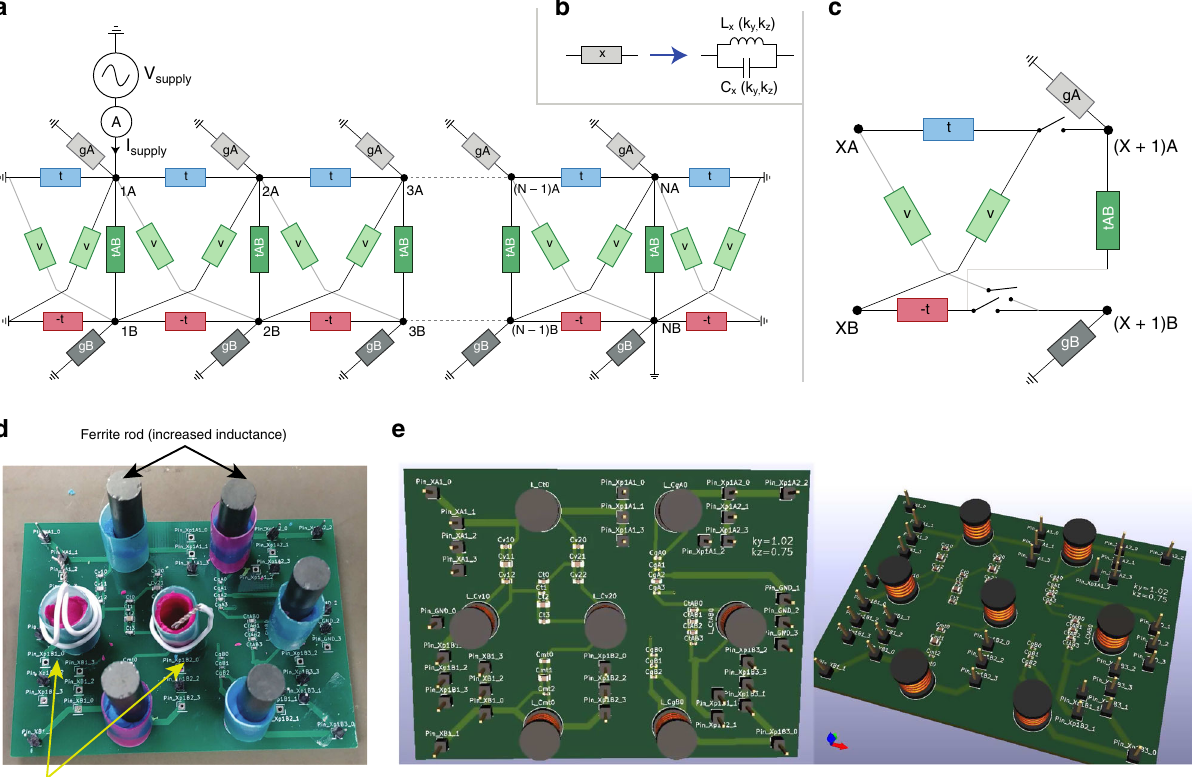
Fig. 6 Schematic and PCB implementation of Hopf-Link experiment. a Schematic of our 2-leg ladder LC circuit array, whose Laplacian takes the form of the Hopf-link at resonance when the component admittances are chosen according to (15) – (18). b Each rectangle in ( a ) corresponds to a parallel combination of an inductor and a logical capacitor whose speci fi cations are indicated in Supplementary Table 1. As explained in the main text, each inductor can be accurately tuned to vary k y , k z near the drumhead region. c Schematic representation of one repeating unit cell of the circuit used to construct fi nal experiment. The switches are set to open when the inductors are being tuned, and closed when the impedance of the entire circuit is measured to map out the drumhead region. d Experimental PCB realization of one repeating unit. Visible are the inductors equipped with ferrite rods or shorted wire loops, which respectively increase/decrease the inductances in a tunable manner. e Renderings of the same PCB to emphasize its physical structure. Each large cylinder represents a variable inductor, while the components pre fi xed by “ C ” represent capacitors that are connected in parallel to form the logical capacitors in Fig. 9. Detailed speci fi cations of these components are given in Supplementary Tables 1 and